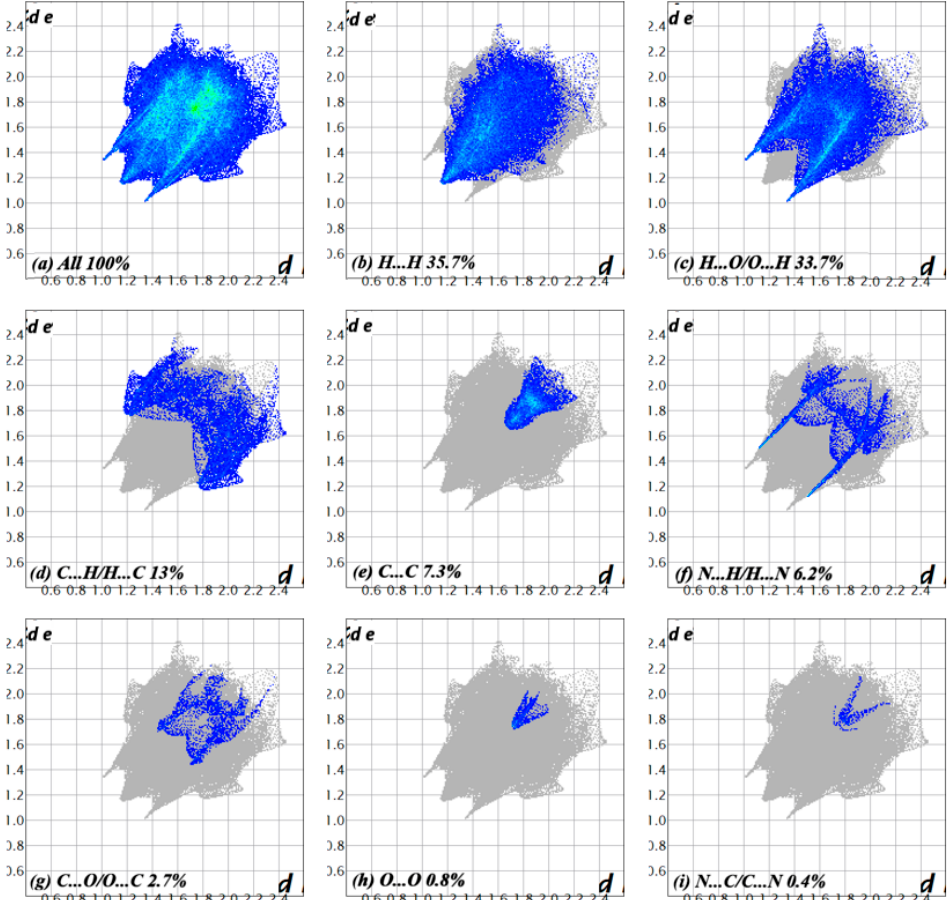
Figure 6. Two-dimensional fingerprint plots for the title compound, showing ( a ) all interactions, and delineated into ( b ) H…H, ( c ) H…O/O…H, ( d ) C…H/H…C, ( e ) C…C, ( f ) N…H/H…N, ( g